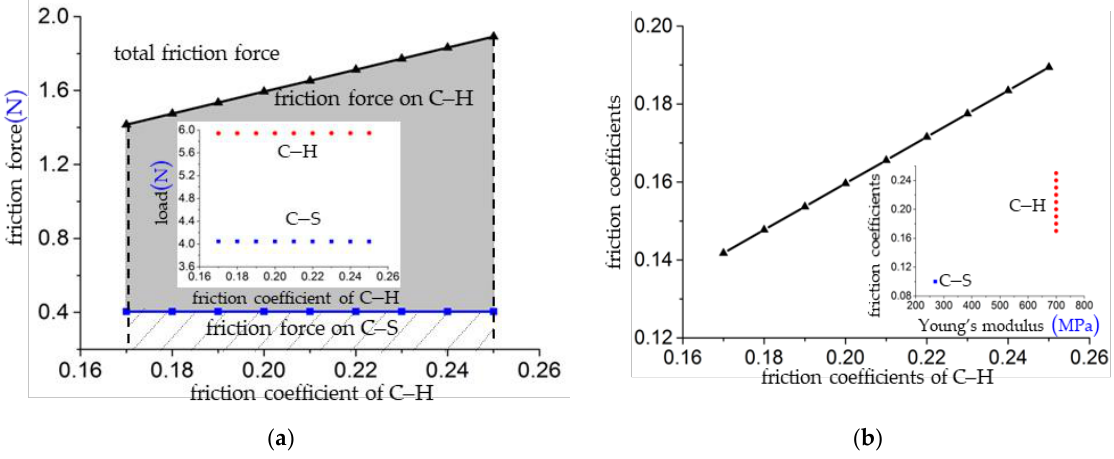
Figure 4. Curves of friction force and friction coefficient for BHSIMs with varied friction coefficients of hard phase. ( a ) friction force (inset is the load); ( b ) friction coefficient (inset is the friction coefficient).